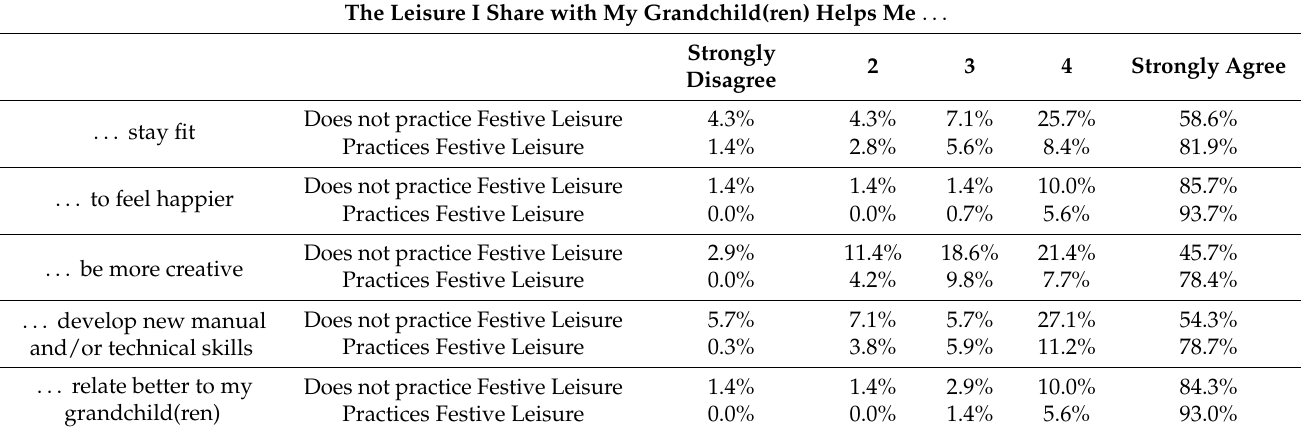
Table 4. Benefits for grandparents who share festive leisure with their grandchildren versus grandparents who do not. The Leisure I Share with My Grandchild(ren) Helps Me . .